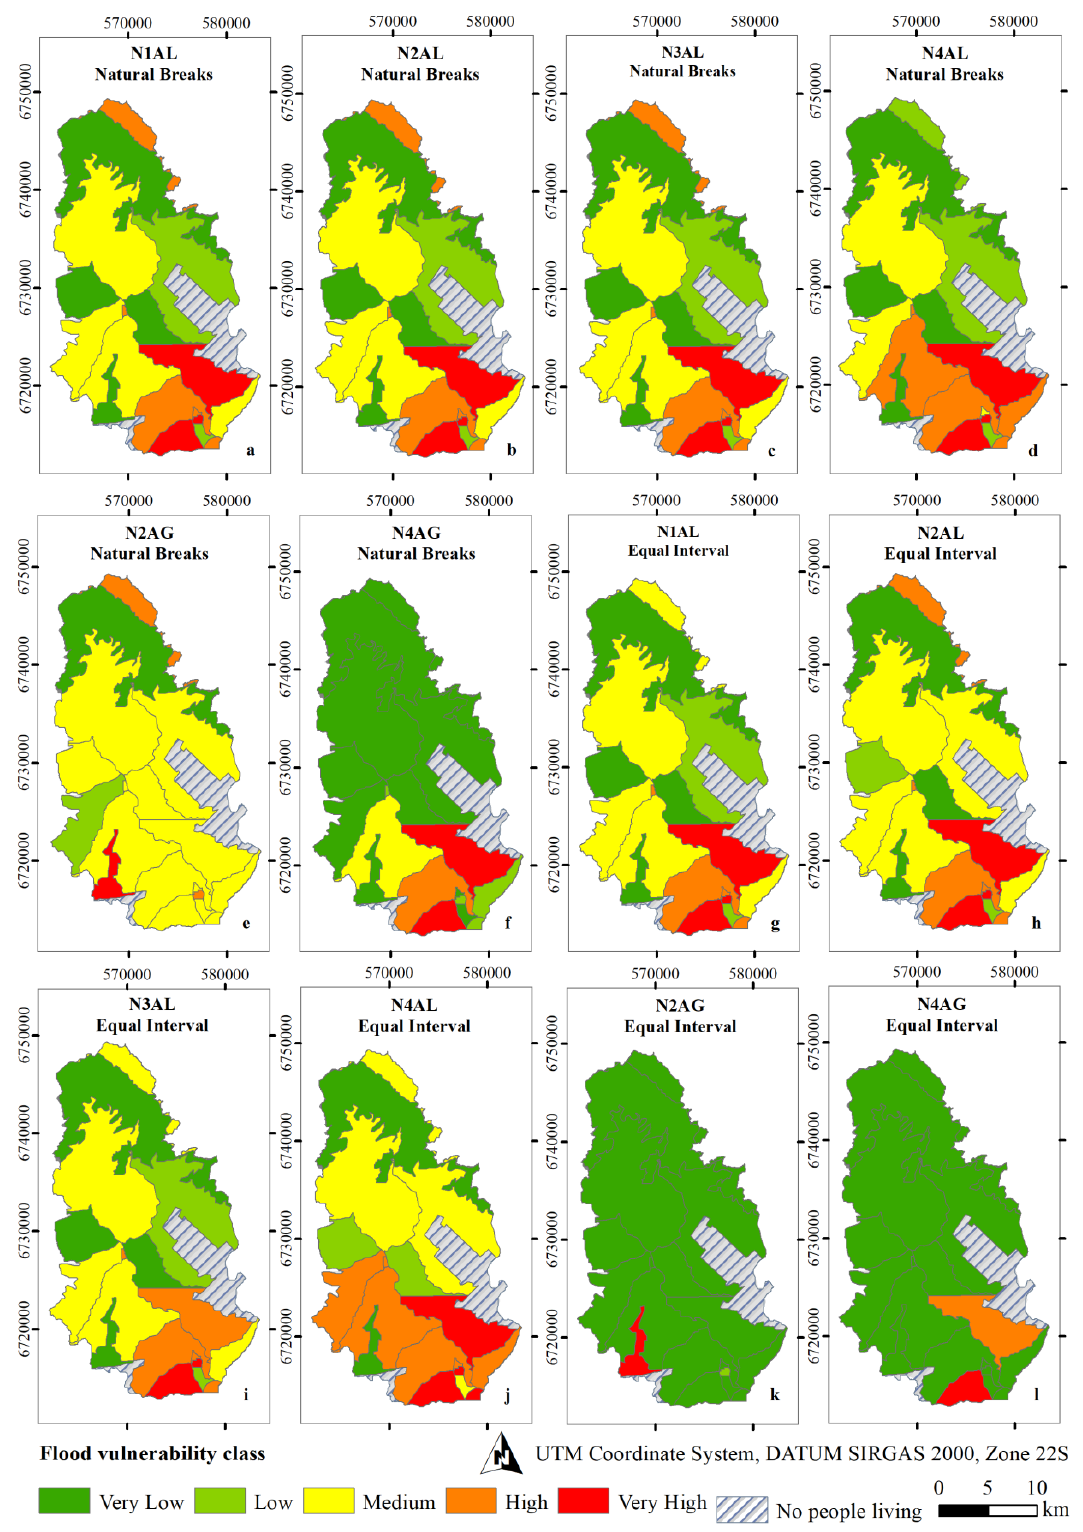
Figure 6. Vulnerability class switches for the different normalization and aggregation methods based on the natural breaks and equal interval classification methods. N1 = Min-max normalization, N2 = Z-scores normalization, N3 = distance to target normalization, N4 = ranking normalization, AL = linear aggregation, and AG = geometric aggregation.